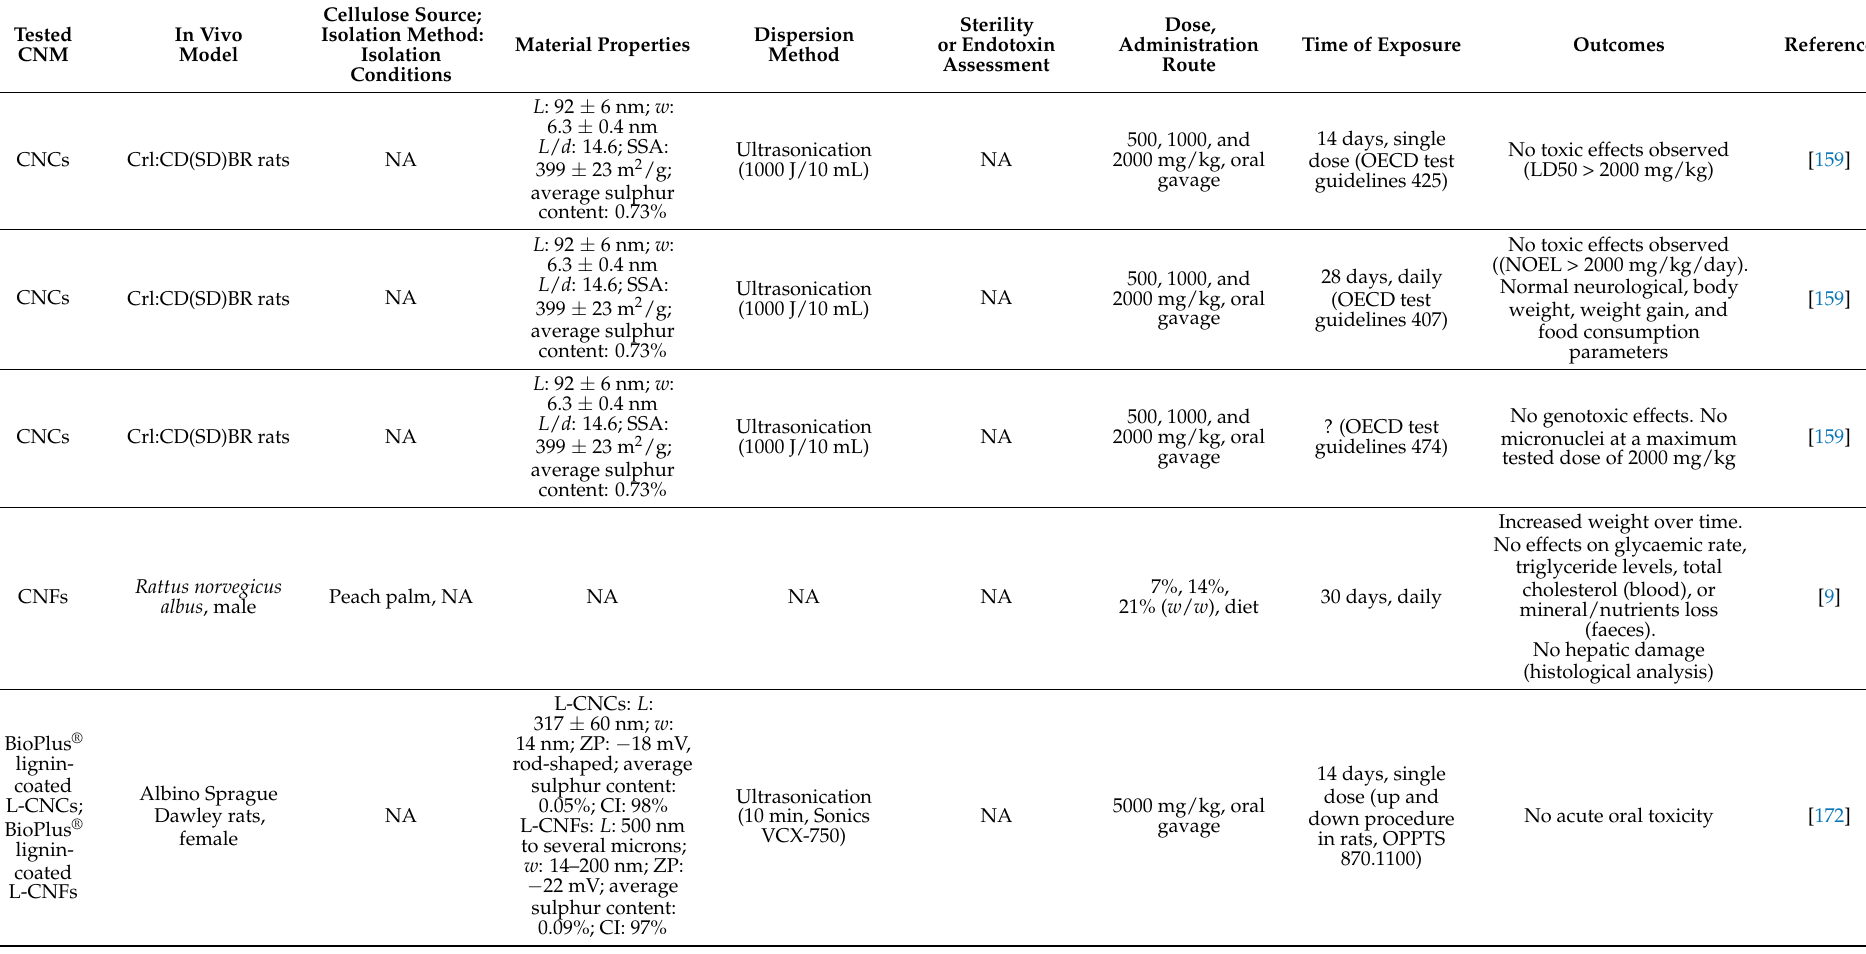
Table 3. Summary of in vivo toxicity studies after oral exposure to